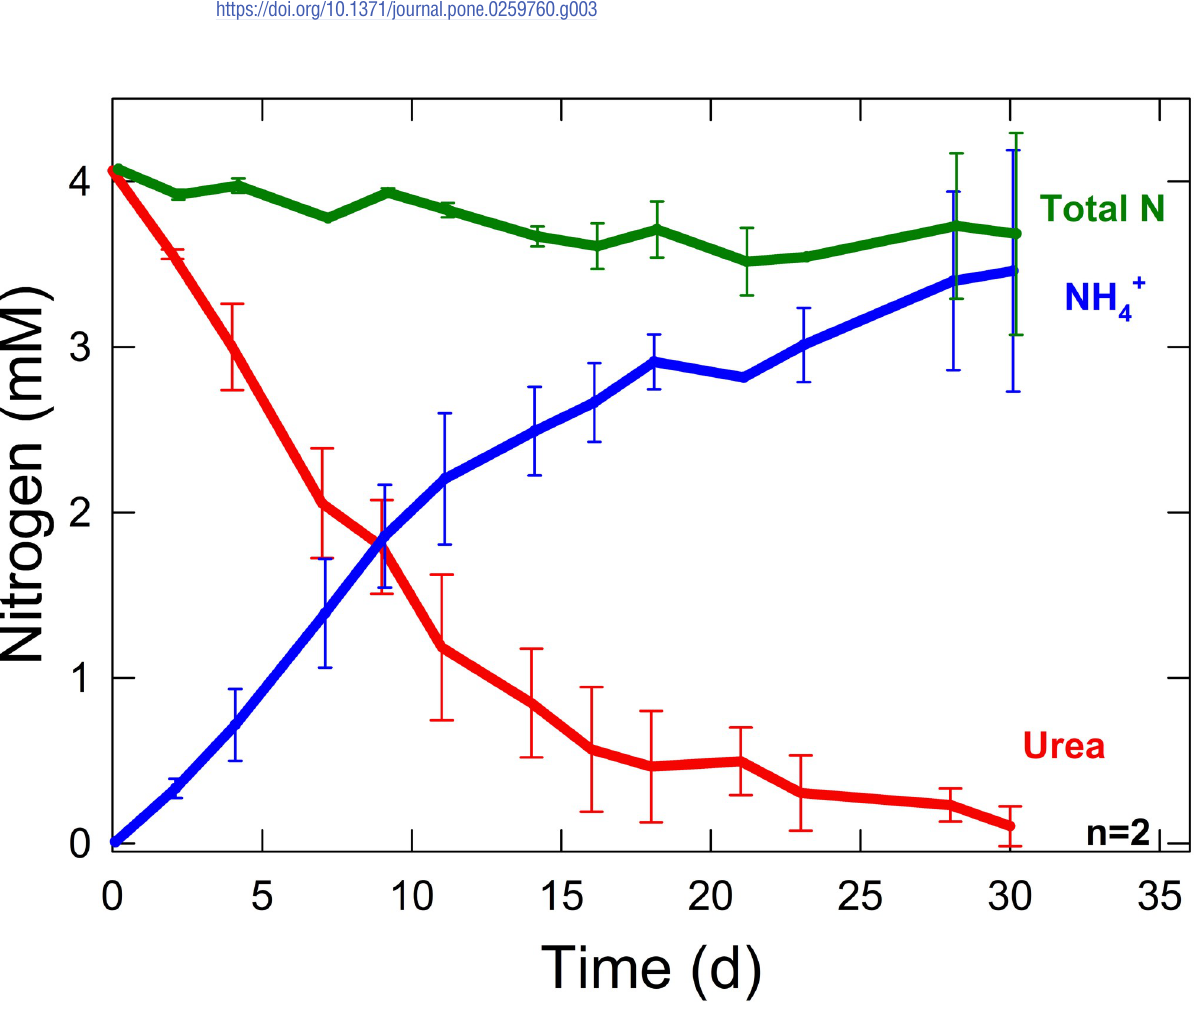
Fig 4. Changes in nitrogen form over time. Concentrations of nitrogen in urea and ammonium over 30 days in recirculating columns (n = 2) controlled at pH 7 with sulfuric acid addition. Total N represents the sum of N from urea and ammonium. Error bars represent standard error, n = 2.